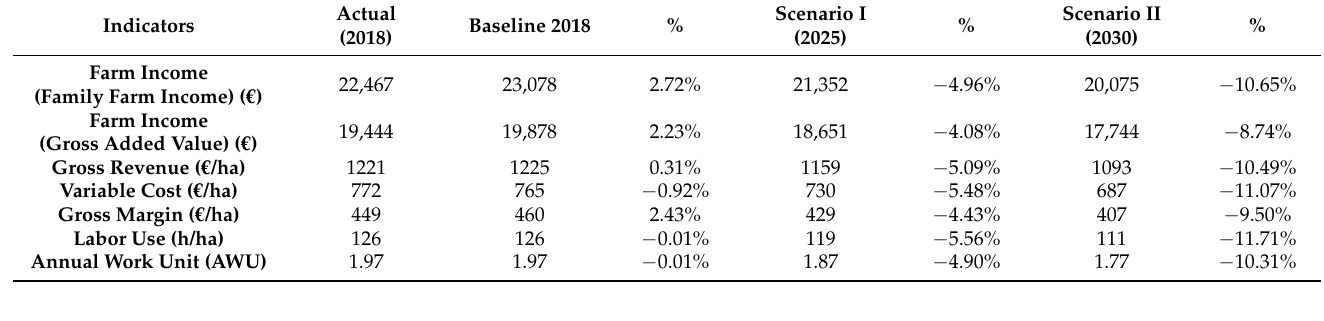
Table 6. Socioeconomic indicators vs. scenario analysis.